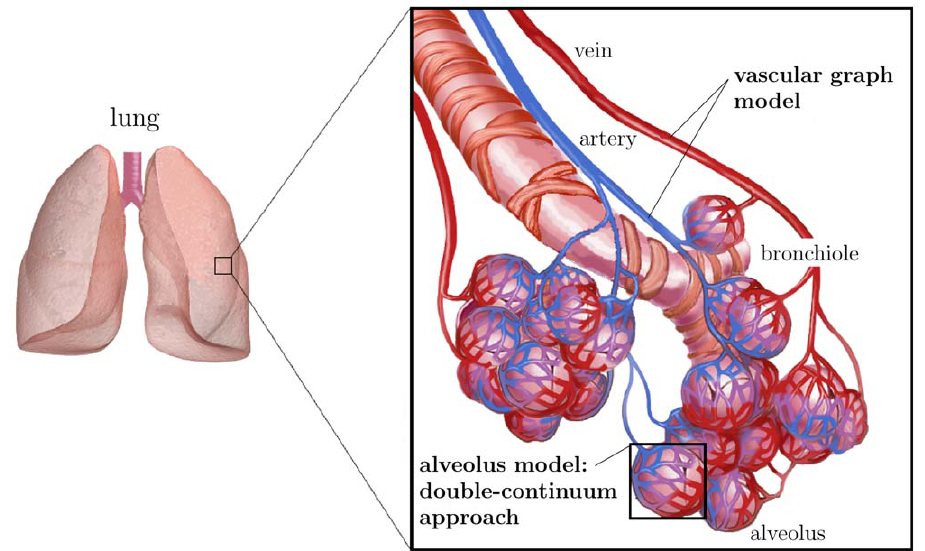
Figure 1. General model concept. The vascular graph model describes the processes occurring in the arteries, arterioles, venules and veins. The alveolus model, a double-continuum approach, represents the processes occurring in the capillary bed and the surrounding tissue (right image according to Terese Winslow).